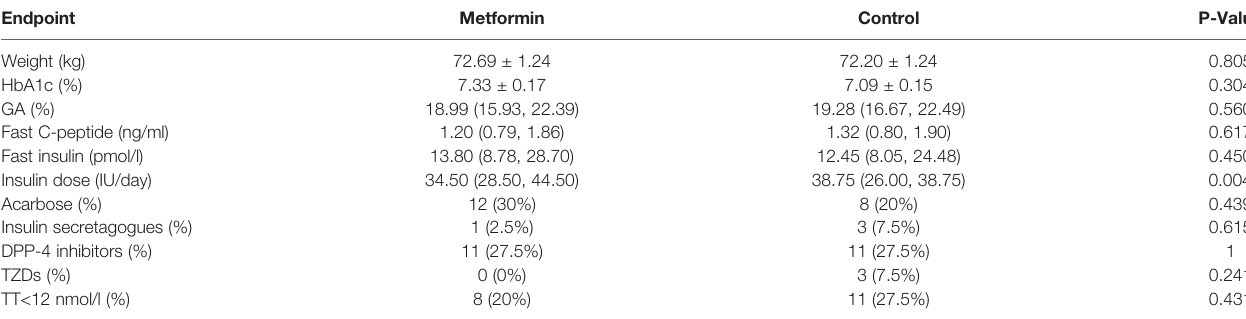
TABLE 2 | Endpoint characteristics of the study